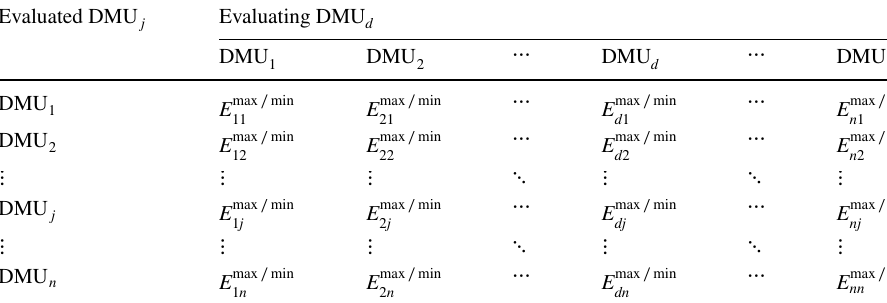
Evaluated DMU j Evaluating DMU